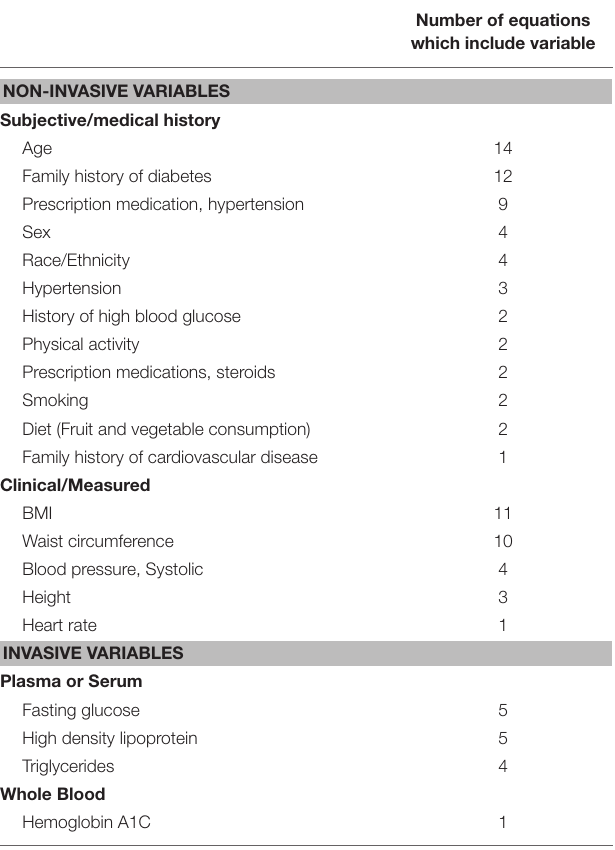
TABLE 2 | Diabetes prediction equation studies: variables included in 15 diabetes equations.